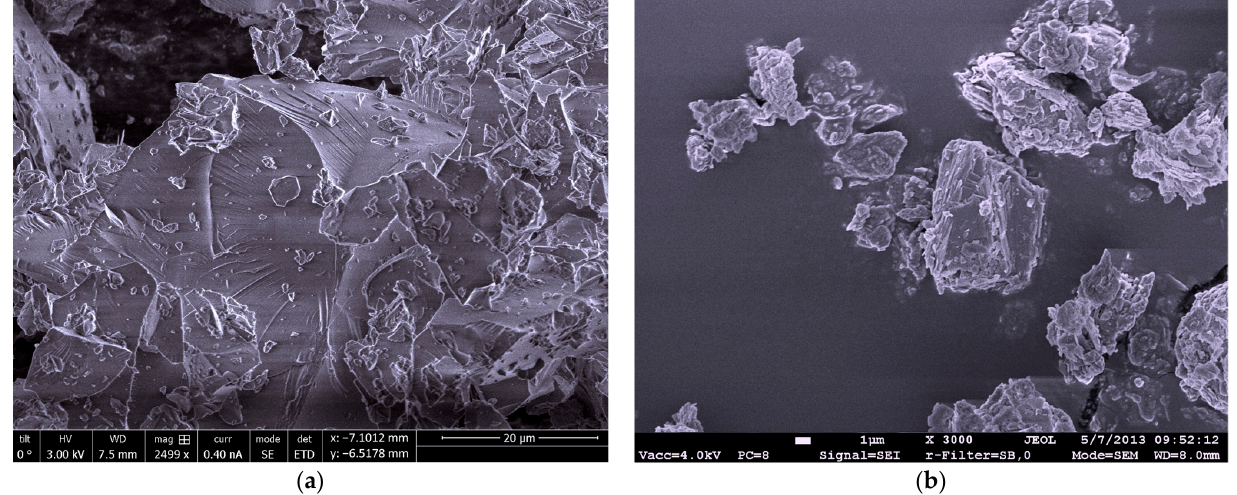
Figure 2. SEM images of binder particles: ( a ) glass powder ( b ) natural zeolite (clinoptilolite).